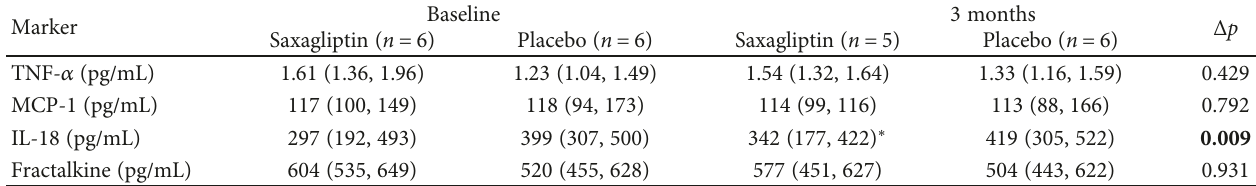
Table 4: Circulating levels of the selected markers before and after treatment in the randomized groups. Median (25, 75 percentiles) are given.